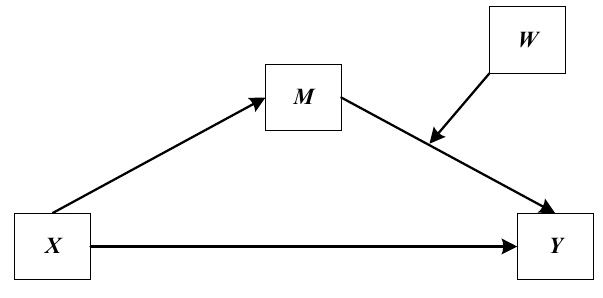
Figure 3. A moderated mediation model (model 14) in the path diagram form.